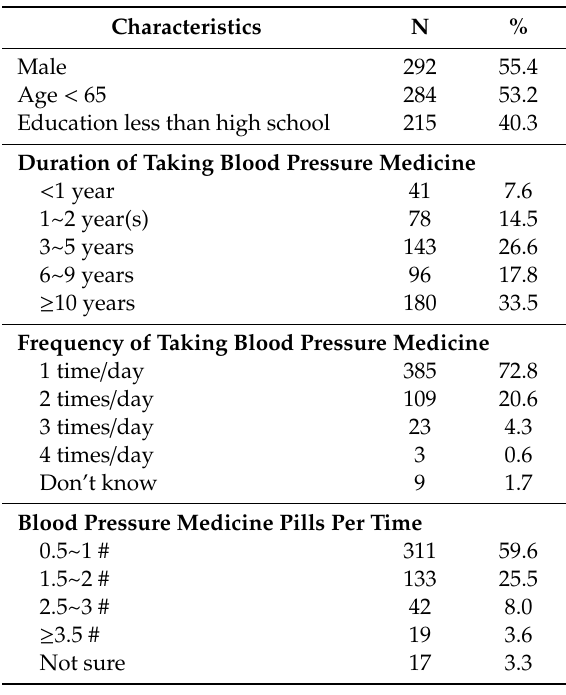
Table 1. Participants’ characteristics.